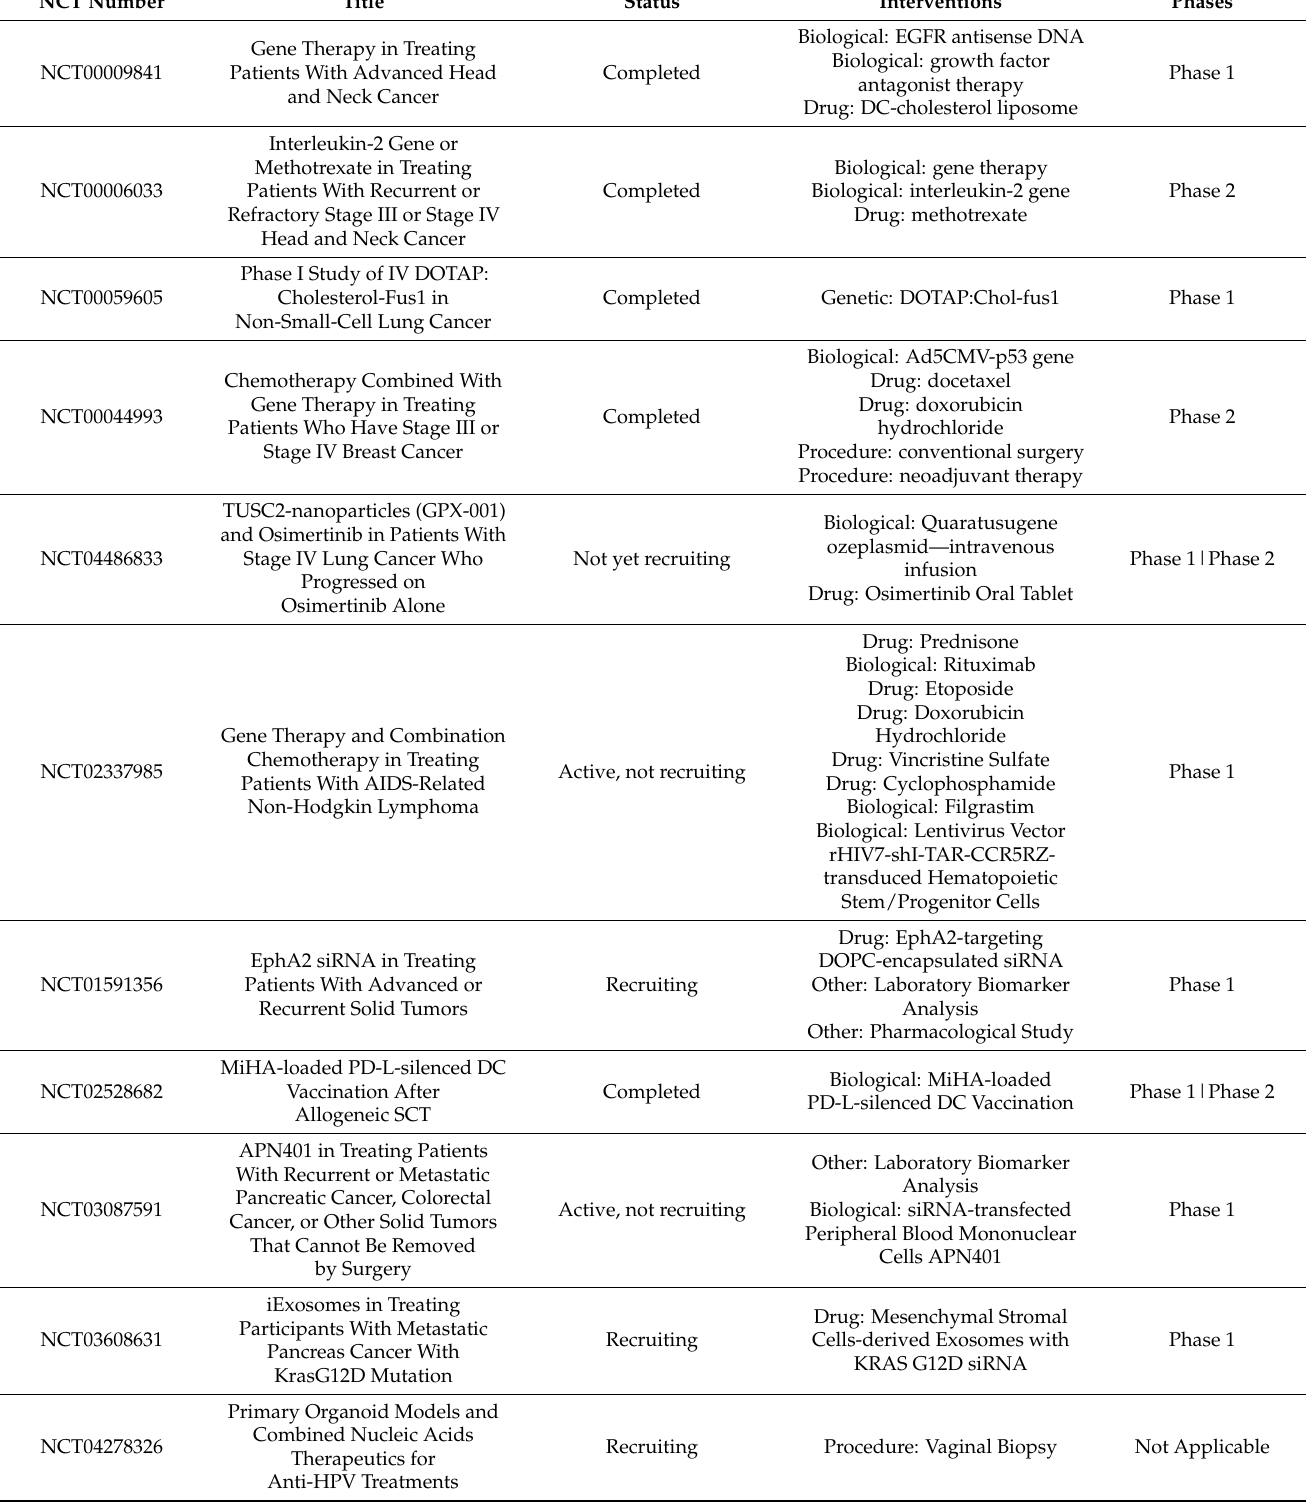
Table 1. Available clinical trials including usage of gene therapy in cancers as of date 3 April 2021 [ClinicalTrials.gov]. NCT